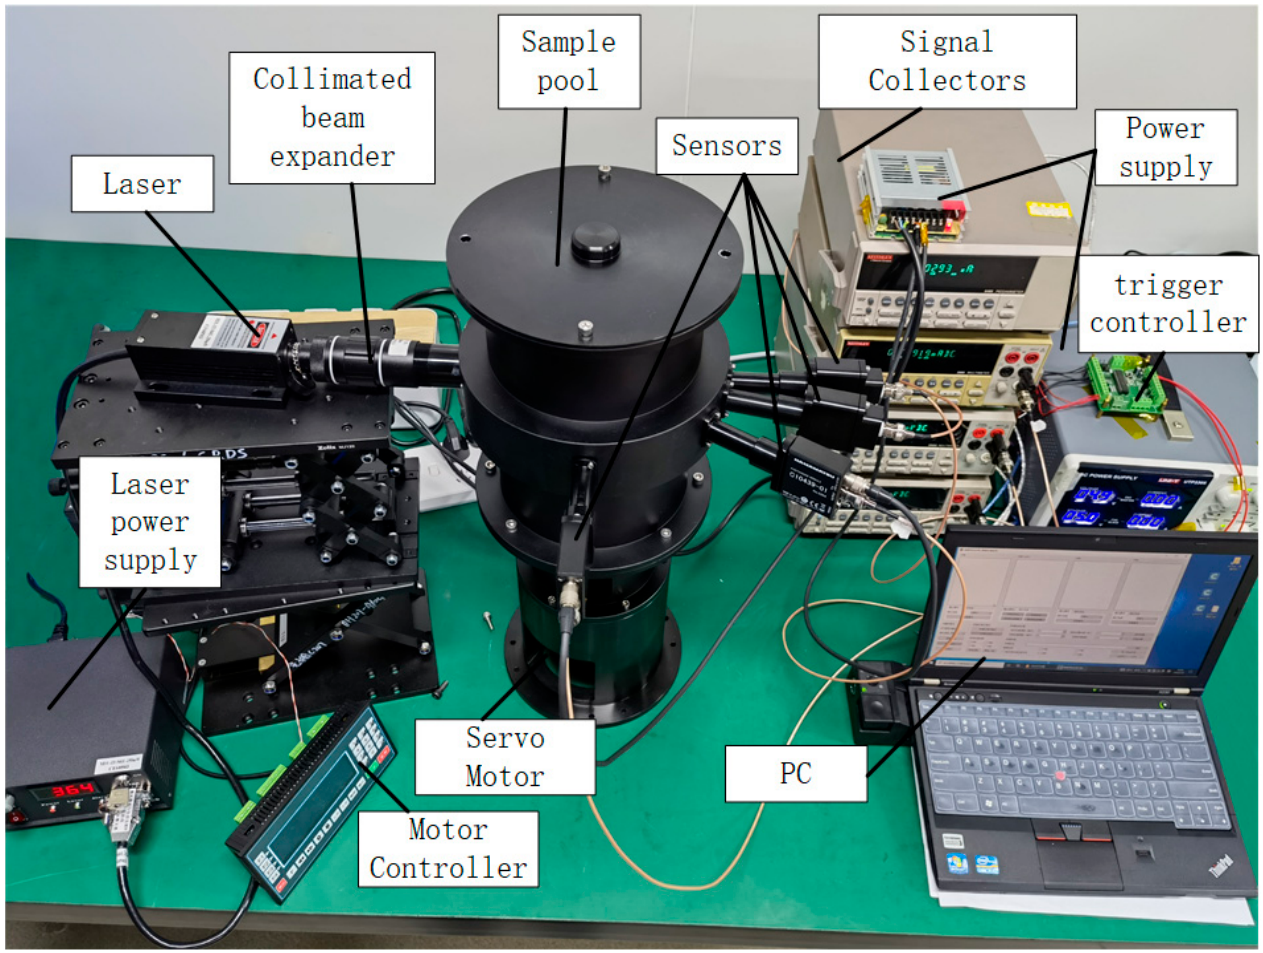
Figure 9. The drawing of the experimental installation.